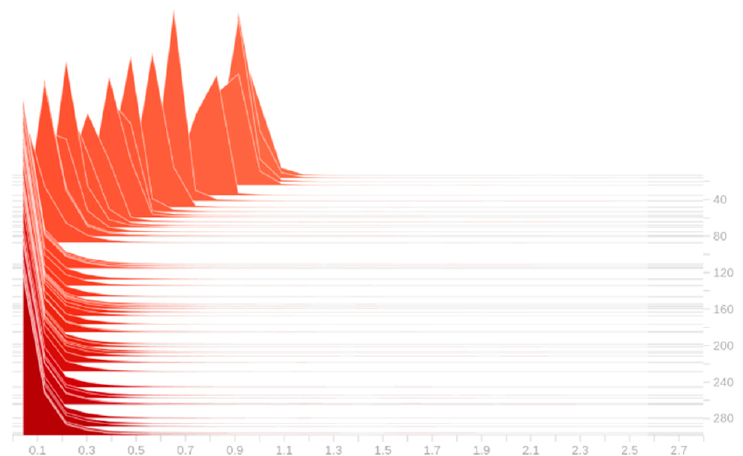
Figure 8. Variation in γ parameters of BN layer during sparse training.